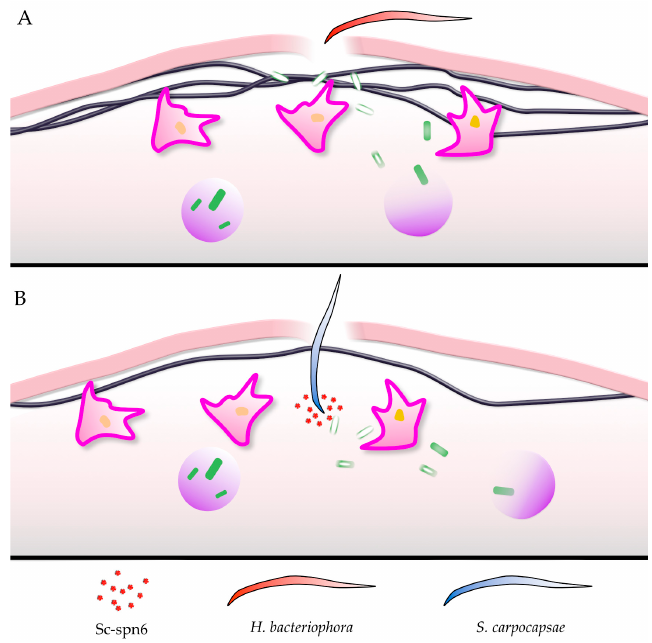
Figure 2. Heterorhabditis bacteriophora ( A ) and Steinernema carpocapsae ( B ) use different strategies to invade Drosophila larvae. Of key importance is that the Steinernema serpin Sc-spn6 prevents the association of phenoloxidase with the growing hemolymph clot, thereby reducing clot formation (see text for further details). The key indicates EPN species and Sc-spn6 found in S. carpocapsae .